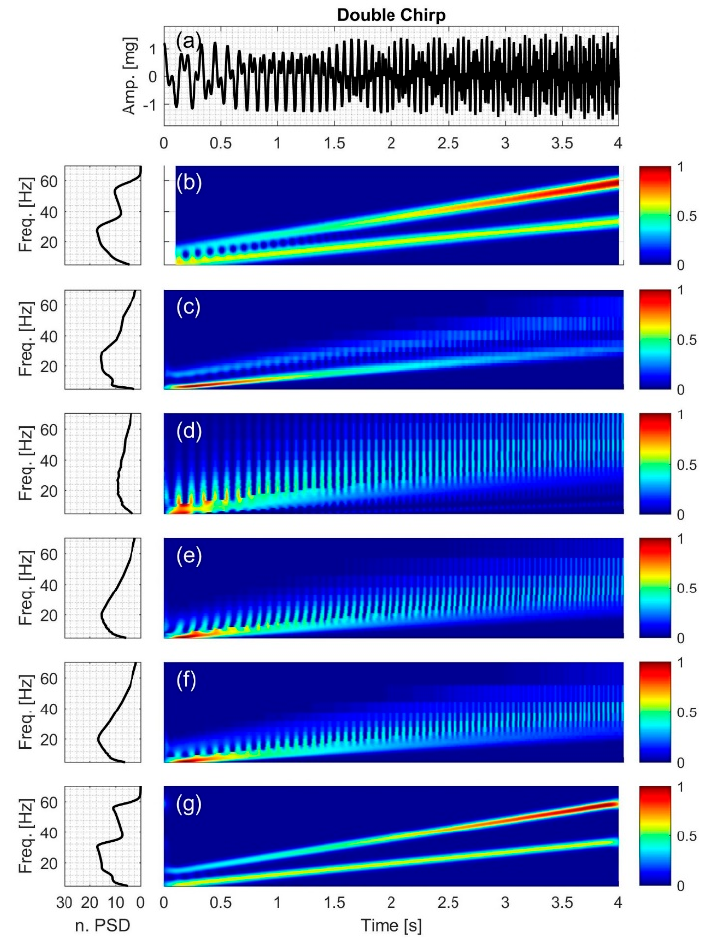
Figure 7. Synthetic test signal with double chirp: ( a ) Time series. Left and right columns show the power spectral density and time-frequency distribution of the signal using: ( b ) STFT; ( c ) CWT-Morl; ( d ) CWT-Haar; ( e ) CWT-db4; ( f ) CWT-Coif5; and ( g ) PCT, respectively.